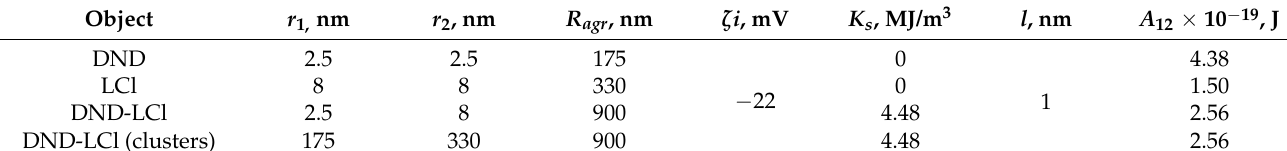
Table 1. The parameters for the particle pair interaction energy evaluation.